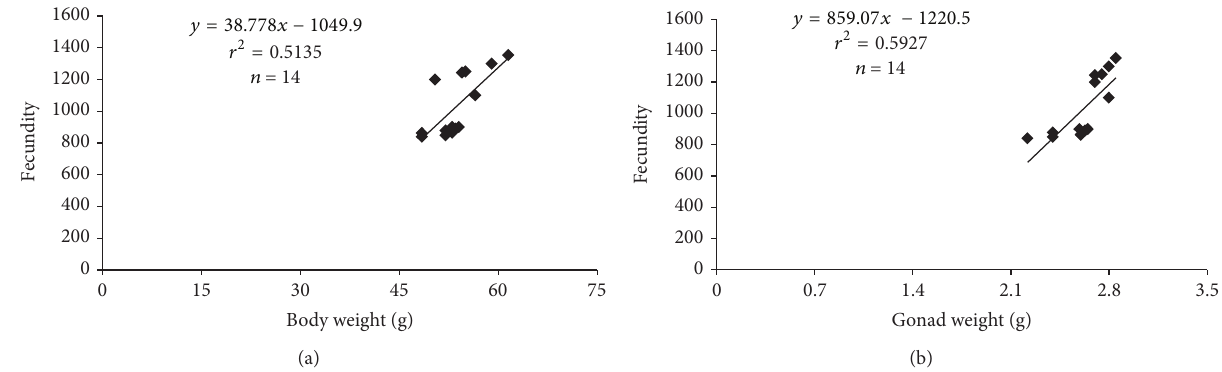
Figure 6: (a) Relationship between fecundity and body weight of mature females (g); (b) relationship between fecundity and gonad weight (g).